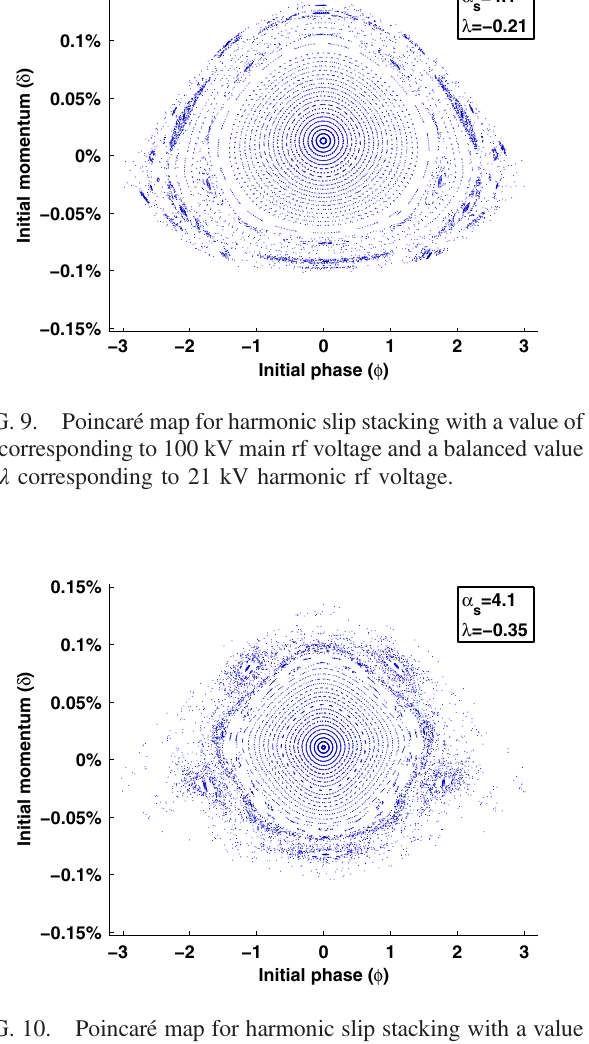
FIG. 10. Poincaré map for harmonic slip stacking with a value of α s corresponding to 100 kV main rf voltage and an unbalanced value of λ corresponding to 35 kV harmonic rf voltage.